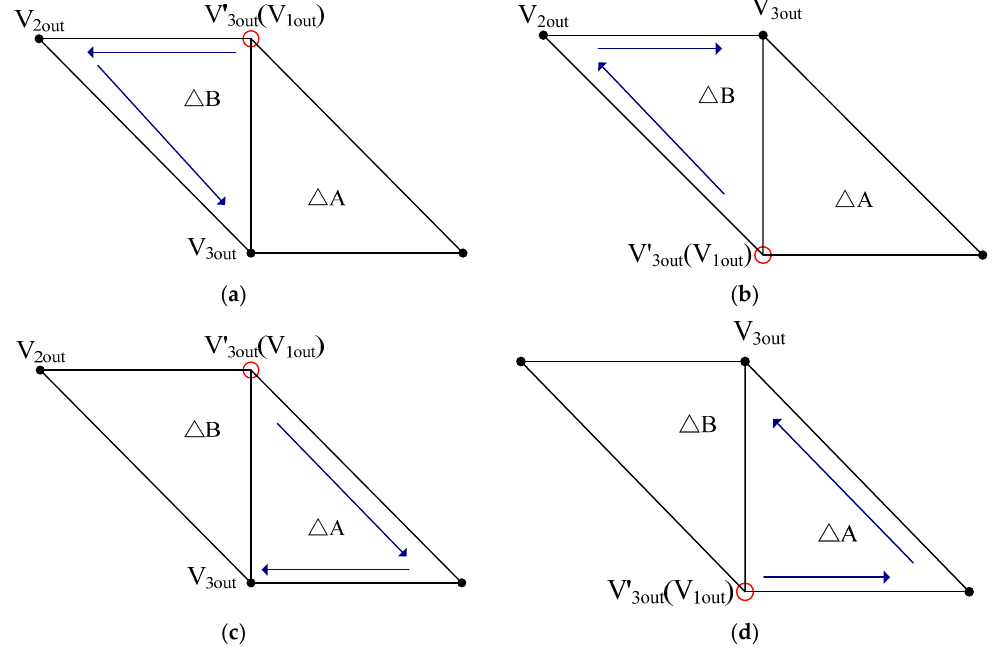
Figure 6. Switching paths in the first kind of quadrangle, ( a ) state 1; ( b ) state 2; ( c ) state 3; ( d ) state 4.